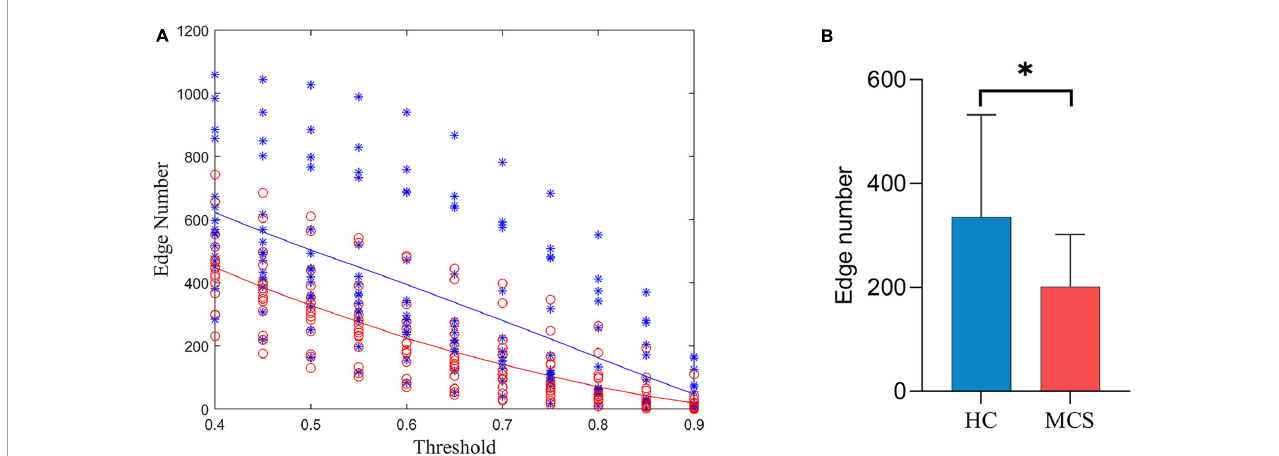
FIGURE3 Differences in the number of edges between HC and MCS groups. (A) Scatter plot: distribution of edges with different thresholds (0.4–0.9, 0.05 interval). Functional connectivity strength larger than the threshold was defined as edge. HC (blue), MCS (red); (B) group differences in the total number of edges. HC, healthy controls; MCS, minimally conscious state. ∗ p < 0.05.